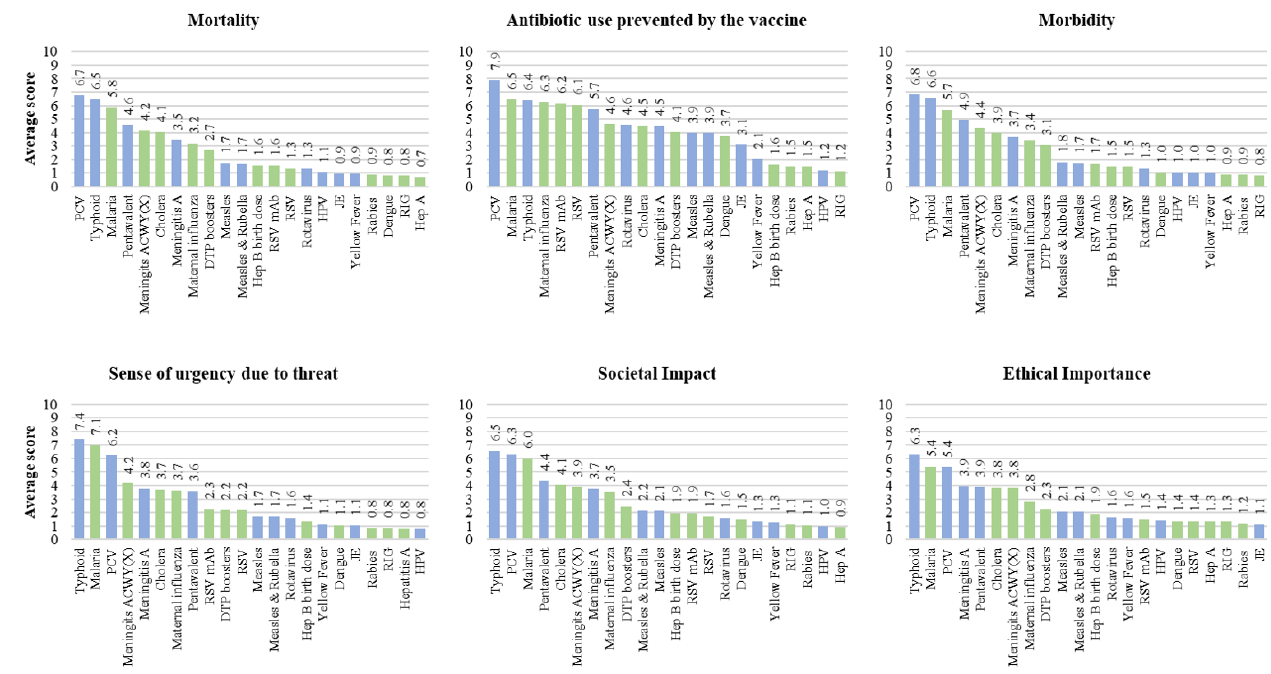
Figure 3. Vaccine impact on AMR, for all criteria, as estimated by experts. ( where 1= least effect of vaccine in future and 10 = greatest effect of vaccine in future) Blue shading = Gavi portfolio vaccines; Green shading = VIS candidate vaccines; numbers above the bars indicate mean criterion scores for each vaccine. PCV – pneumococcal conjugate vaccine; Pentavalent vaccine (diphtheria, pertussis, tetanus, hepatitis B and Haemophilus influenzae type B); DTP – diphtheria, tetanus & pertussis; RSV – Respiratory syncytial virus; mAb - monoclonal antibodies; Hep B – Hepatitis B; JE – Japanese encephalitis; HPV – Human papillomavirus; Hep A – Hepatitis A; RIG – Rabies